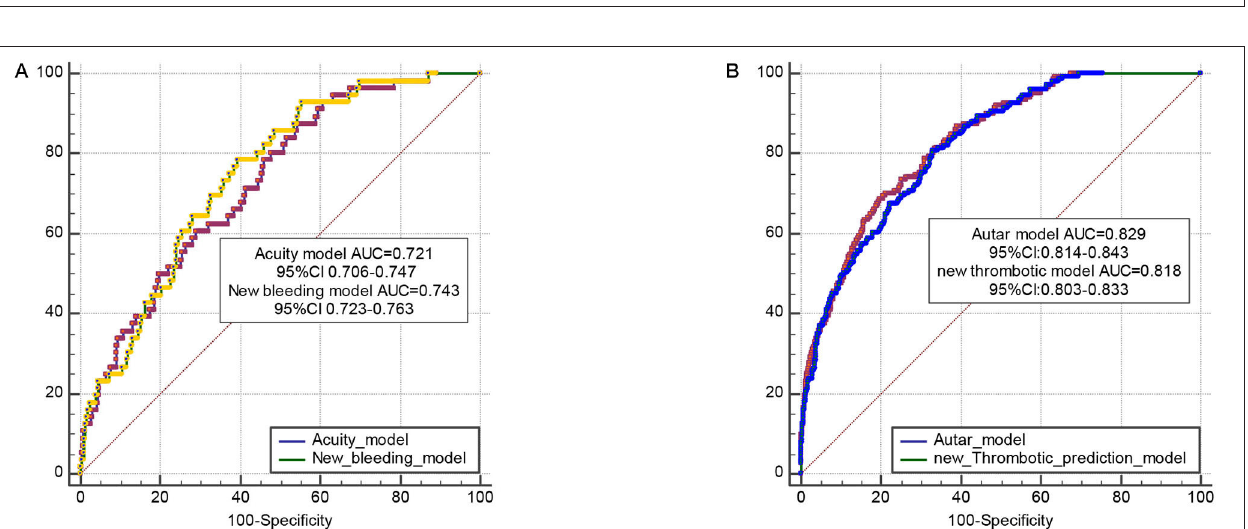
FIGURE 3 | (C) Cumulative 3-year incidence of major bleeding events ( p < 0.001), MACEs ( p < 0.001), cardiac-caused death ( p < 0.001), and all-caused death ( p < 0.001) according to the major bleeding risk score categories in the derivation cohort ( N = 2,084). (D) Cumulative 3-year incidence of major bleeding events ( p <